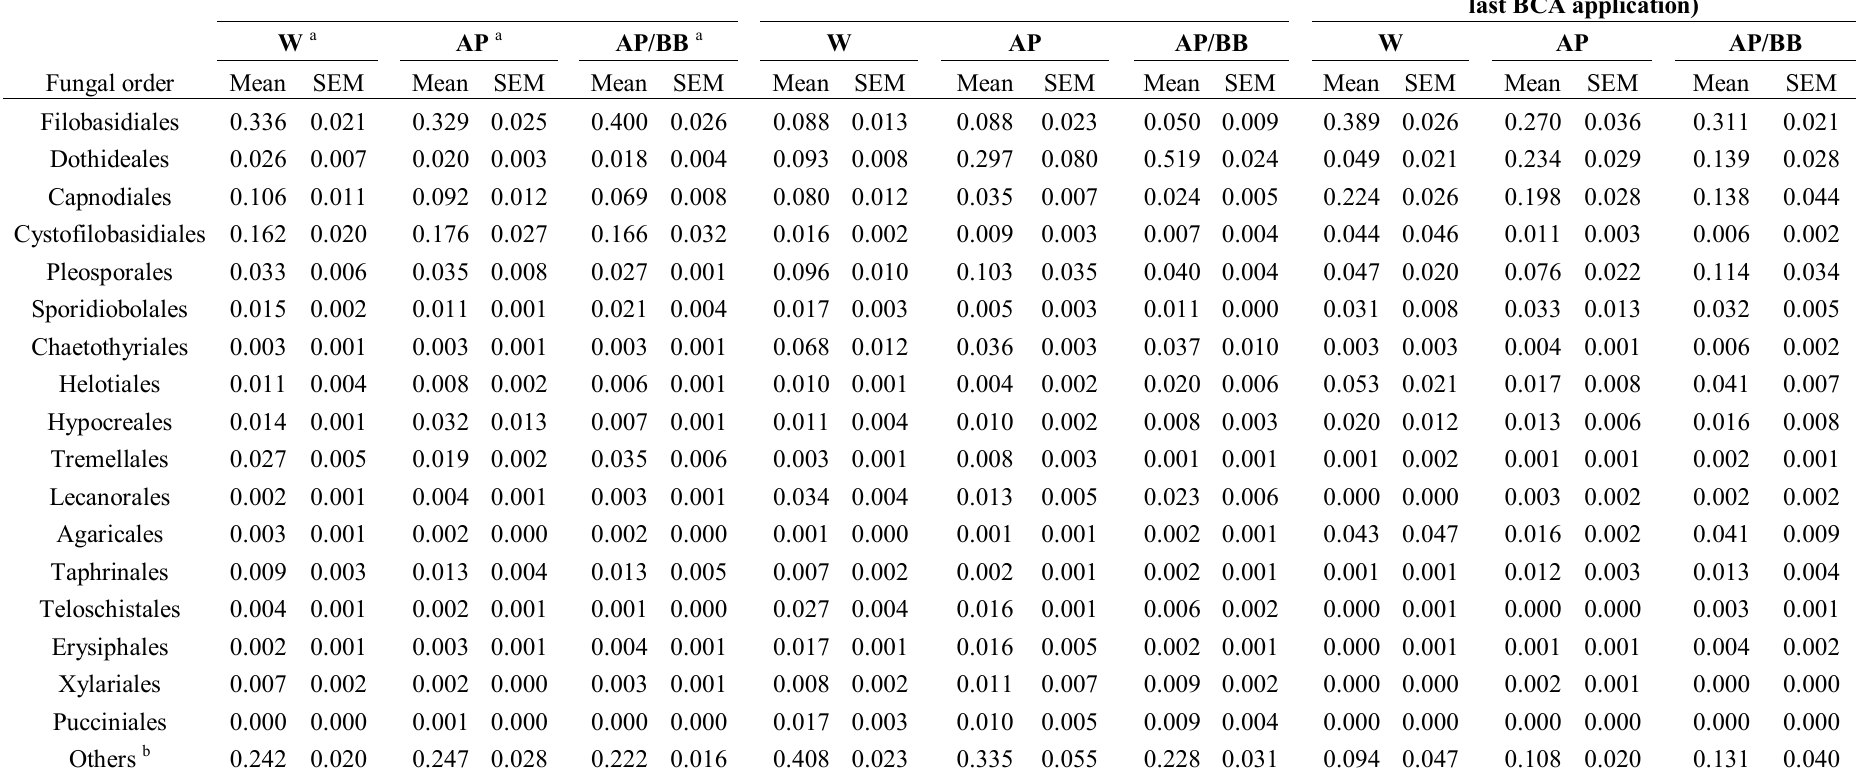
Table 2. Relative abundance of ITS rRNA reads assigned to fungal orders in the strawberry phyllosphere at three distinct phenological stages (BBCH 60, BBCH 73, and BBCH 93) in 2011 as influenced by treatments with Aureobasidium pullulans as a single strain treatment (AP) or co-inoculated with Beauveria bassiana (AP/BB) through commercial formulations. The control (W) was treated with water from a lotic